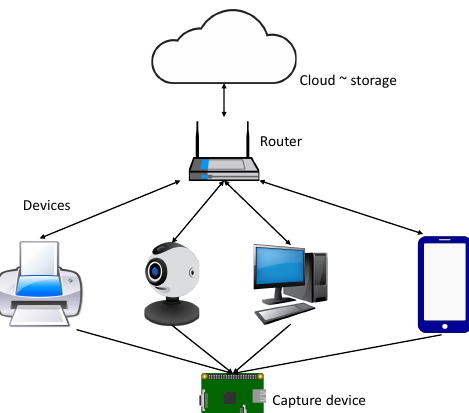
Figure 4. Capture device listening for capture data sent via programs installed on network devices.